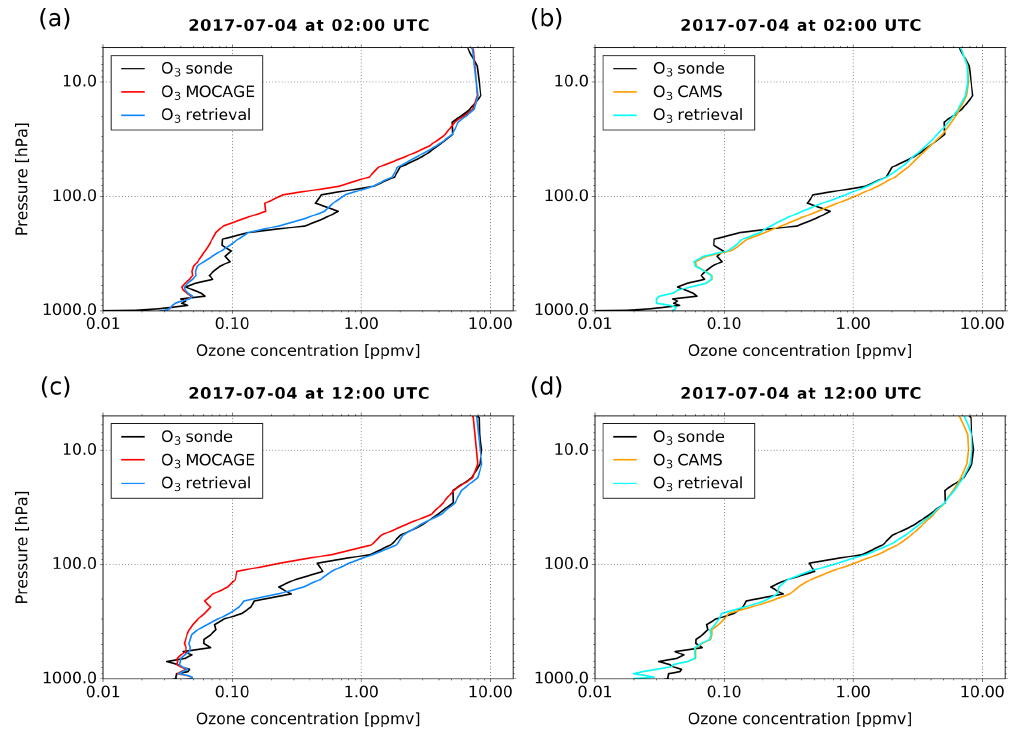
Figure 12. Ozone in situ profile in black compared to O 3 a priori profile from MOCAGE in red and O 3 retrieval profile from CrIS in blue for in situ sounding from 4 July 2017 at 02:00UTC (a) and 4 July 2017 at 12:00UTC (c) . Ozone in situ profile in black compared to O 3 a priori profile from CAMS in orange and O 3 retrieval profile from CrIS in cyan for in situ sounding from 4 July 2017 at 02:00UTC (b) and 4 July 2017 at 12:00UTC (d) .